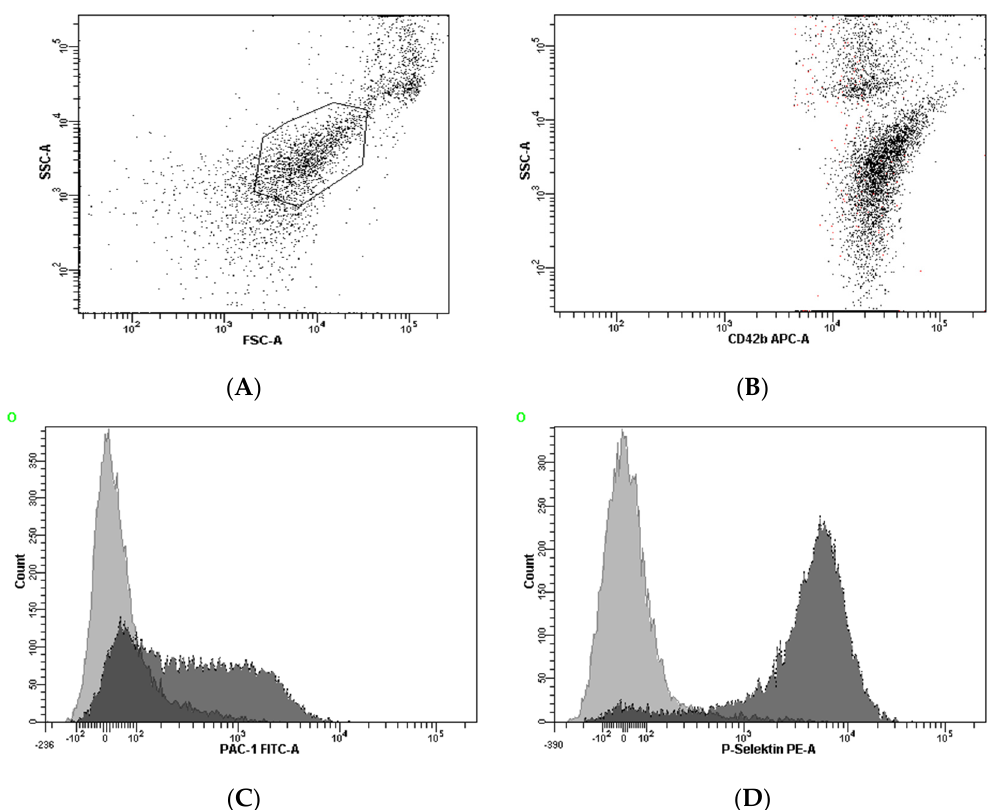
Figure 1. Gating strategy for the identification of the platelet population and the assessment of platelet activation. The platelet population was identified by its characteristics in the forward scatter versus side scatter plot ( A ). For analyses, this population was further identified by plotting CD42b versus side scatter ( B ). Binding of the antibodies against activated GPIIb/IIIa and P-selectin was determined in histograms for PAC-1 and P-selectin, respectively ( C ), ( D ).